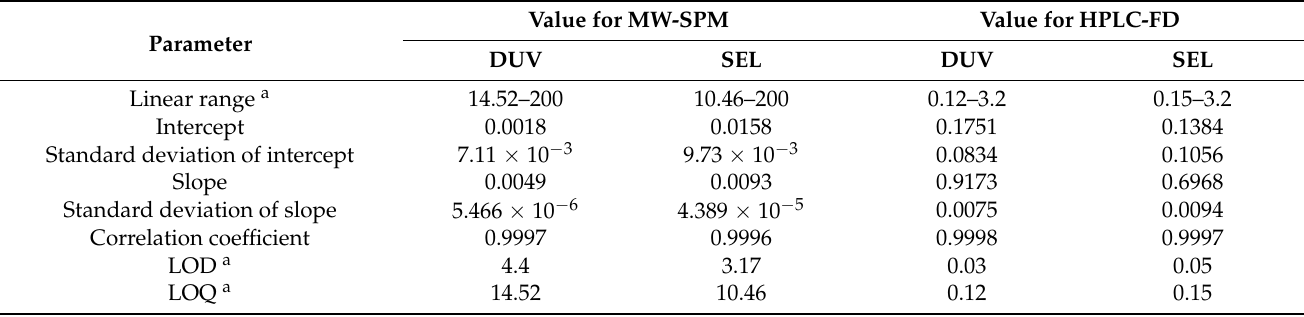
Table 3. Calibration parameters for the determination of DUV and SEL by the proposed MW-SPM and